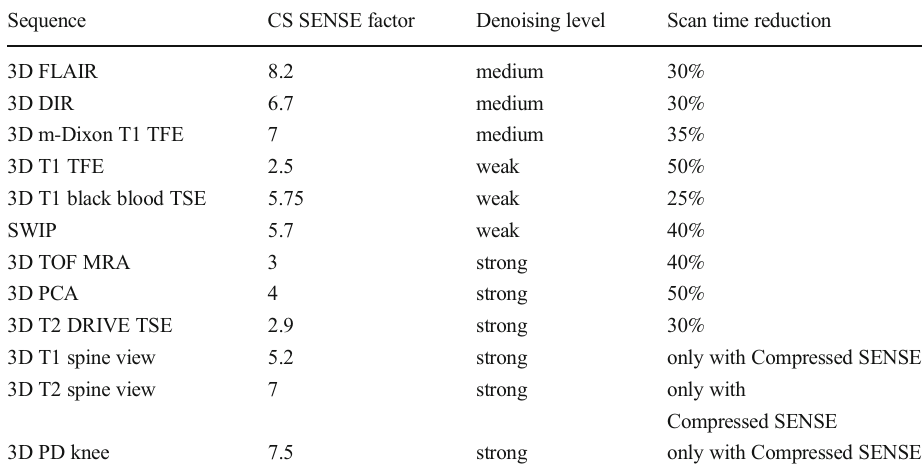
Table 1 Compressed SENSE factors and denoising levels